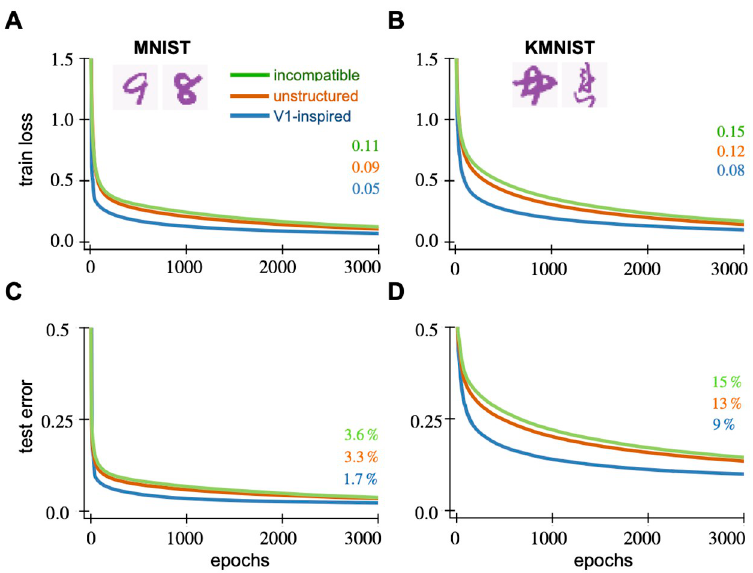
Fig 8. V1 weight initialization for fully-trained networks enables faster training on digit classification tasks. We show the average test error and the train loss of fully-trained neural networks against the number of training epochs. The hidden layer of each network contains 1,000 neurons. We generate five random networks and average their performance. The solid lines show the average performance metric across five random networks while the shaded regions represent the standard error. The top row shows the network’s training loss on (A) MNIST and (B) KMNIST tasks. The bottom row shows the corresponding test error on (C) MNIST and (D) KMNIST tasks. When their covariance parameters are tuned properly, V1-initialized networks achieve lower training loss and test error under fewer epochs on both MNIST and KMNIST tasks. The network performance is no better than unstructured initialization when the weights are incompatible with the